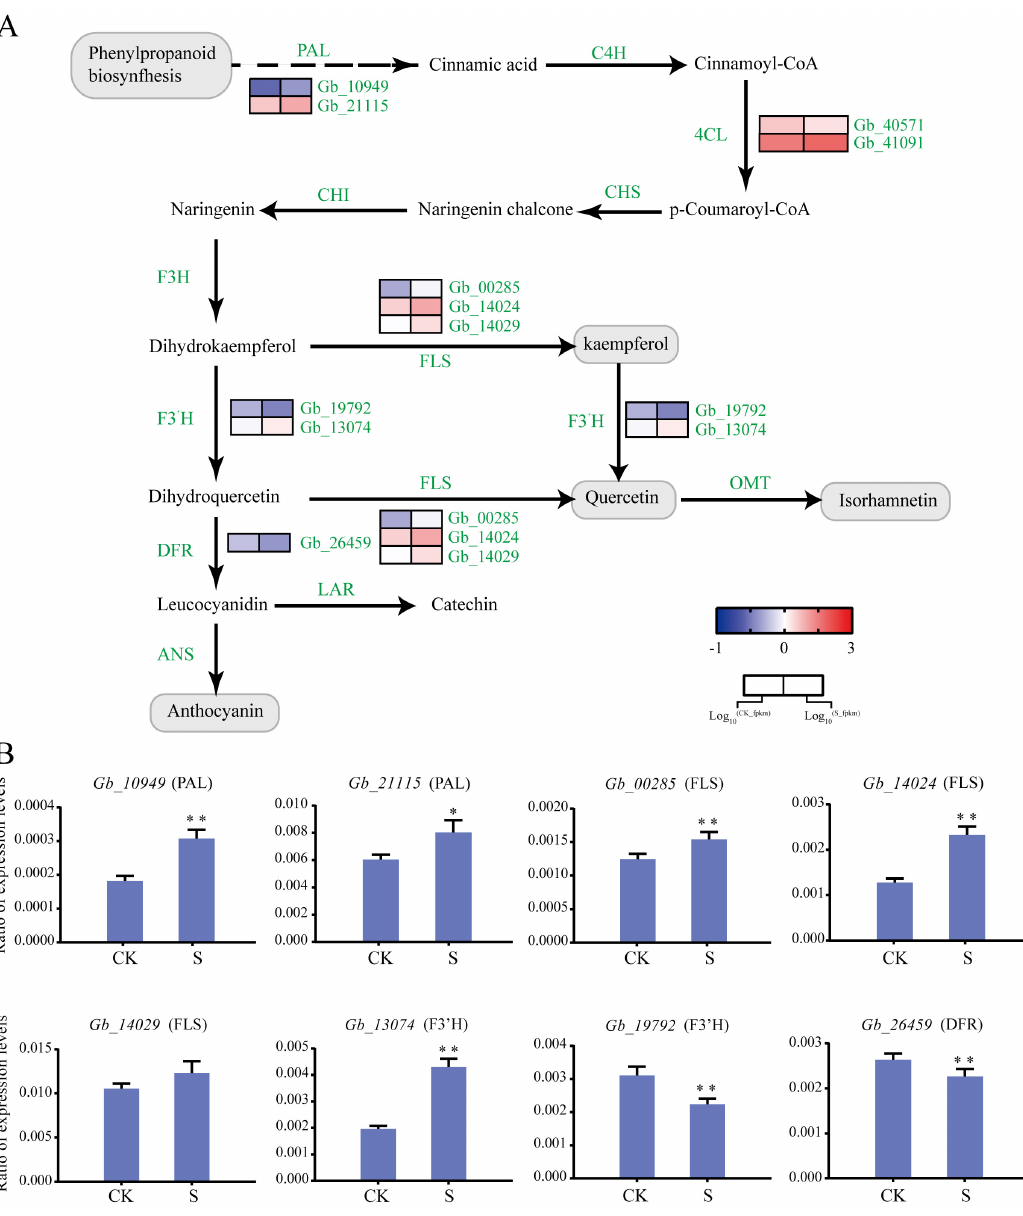
Figure 6. Differentially expressed structural genes involved in G. biloba flavonoid biosynthesis. ( A ) Expression profiles of DEGs involved in flavonoid biosynthesis after NaCl treatment. The FPKM range from low (blue) to high (red) is − 1 to 3, respectively. ( B ) RT-qPCR analysis of eight flavonoid biosynthesis-related structural genes amplified from the RNA extracted from G. biloba seedling leaves grown under 0 and 100 mmol / L NaCl conditions. Leaves were harvested on day 14. * p < 0.05; ** p < 0.01. The vertical bars indicate SD ( n = 3).